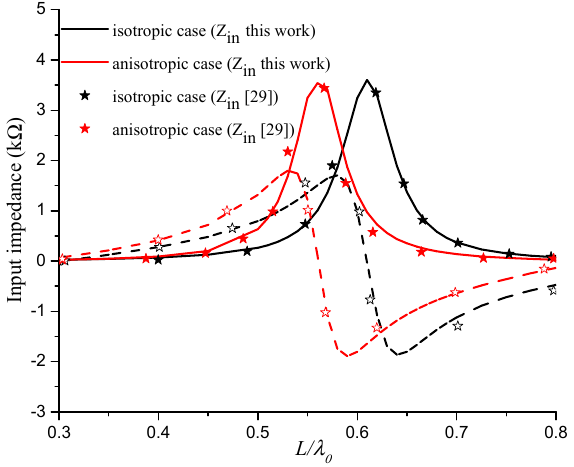
Figure 2. Input impedance of the dipole printed on isotropic and anisotropic layers.